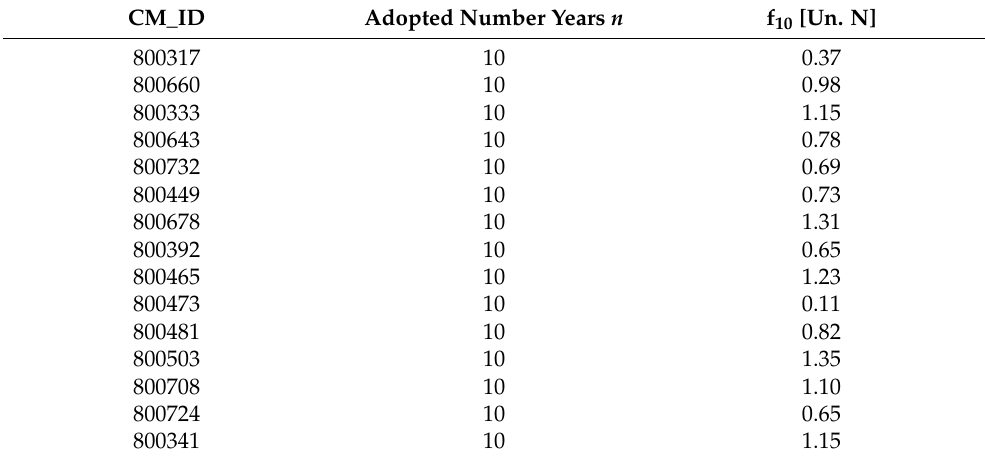
Table 6. Profitability of agricultural production due to land consolidation in the adopted